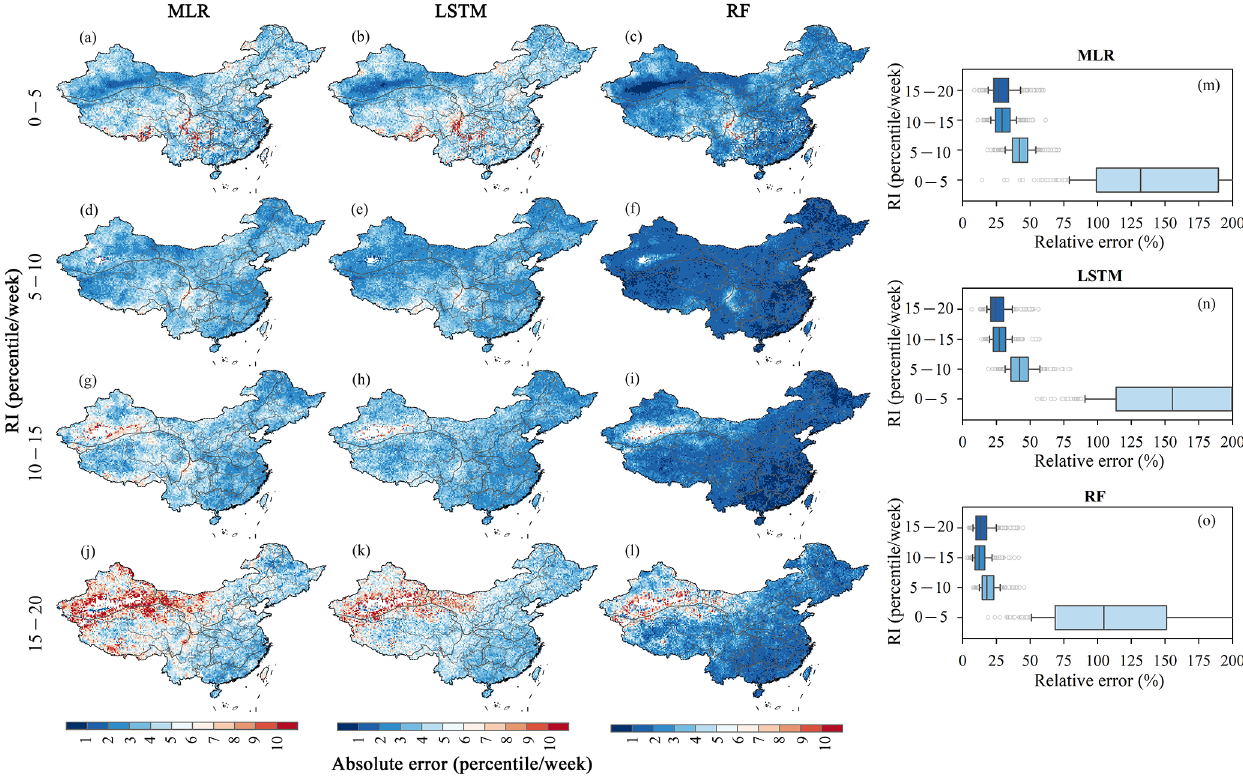
Figure 7. Spatial pattern of the absolute errors and box plots of the relative errors of the RI estimated by the MLR, LSTM, and RF methods against observed RI at four percentile